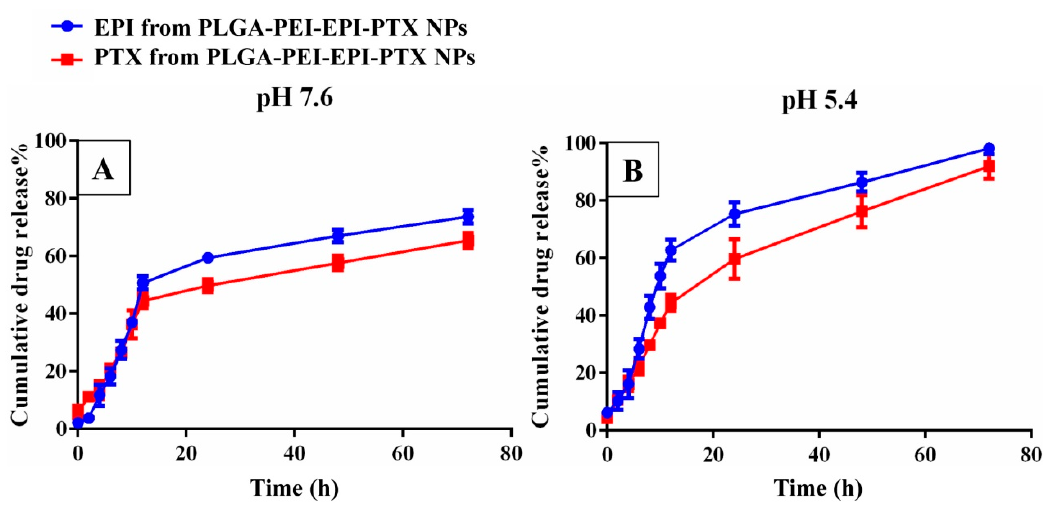
Figure 4. In vitro drug release study of epirubicin and paclitaxel from PLGA ‐ PEI ‐ EPI ‐ PTX NPs at ( A ) pH 7.5 and ( B ) pH 5.4.